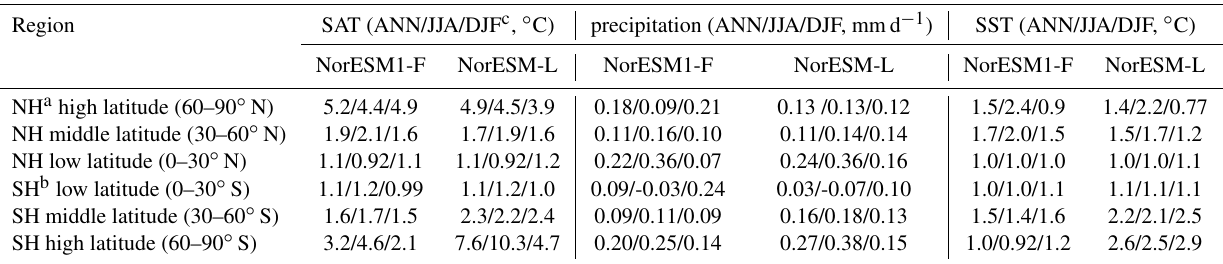
Table 3. Regional averaged annual and seasonal anomalies between the Pliocene and preindustrial experiments according to NorESM1-F and NorESM-L in PlioMIP2 for surface air temperature (SAT), precipitation, and sea surface temperature (SST).